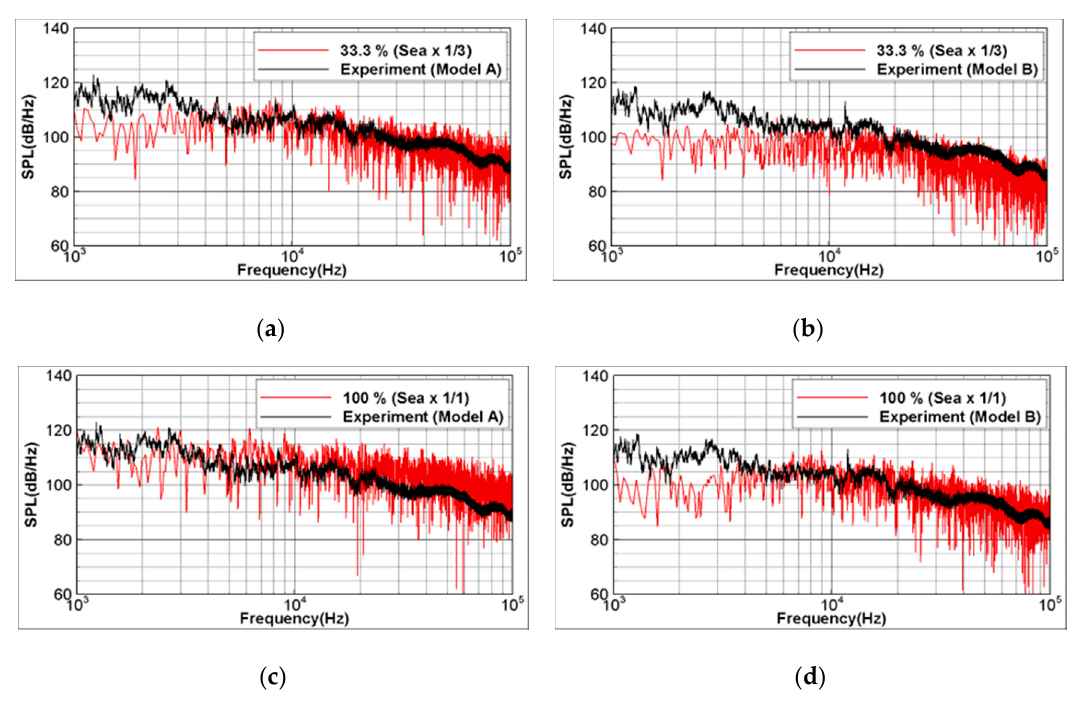
Figure 23. Predicted acoustic pressure spectrum of Model-A and Model-B for di ff erent initial nuclei distributions: ( a , b ) 33.3% of number concentration density (NCD) of seawater condition; ( c , d ) NCD of seawater condition.